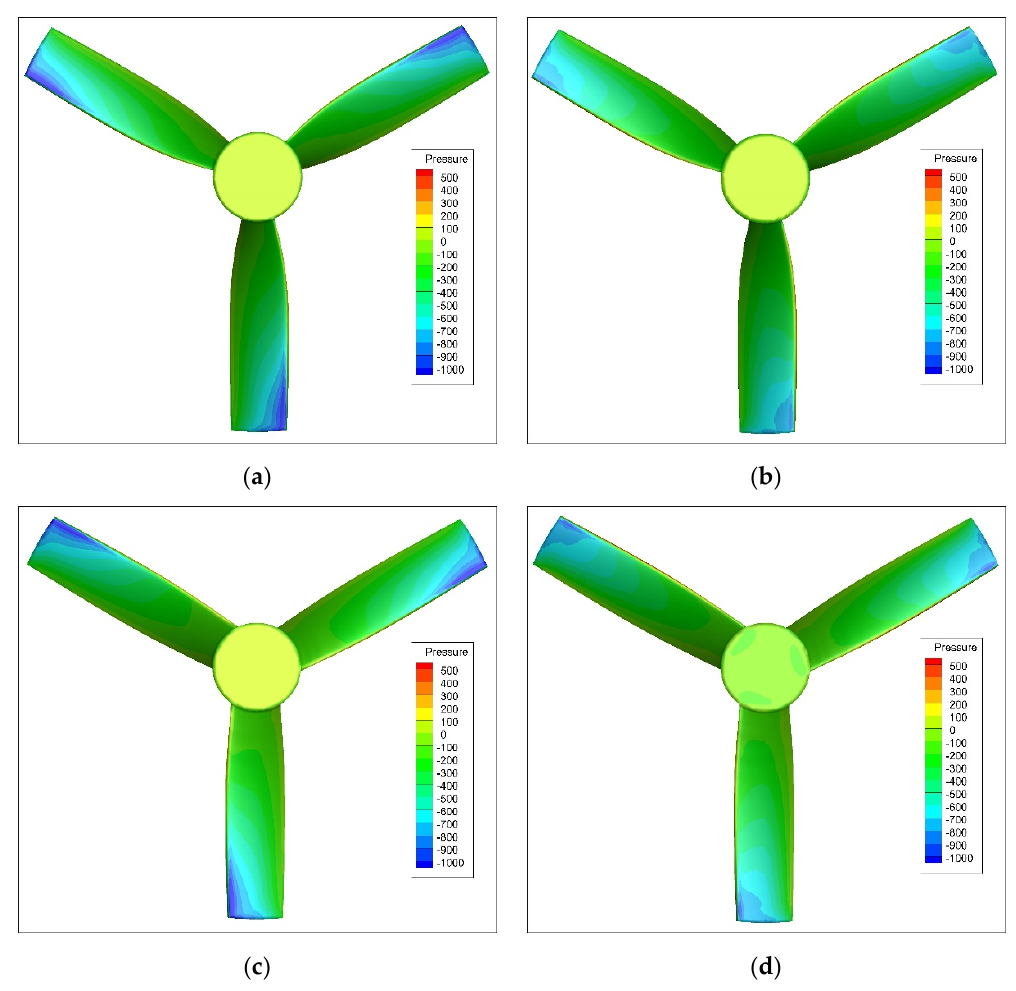
Figure 17. Static pressure contours of ducted single and coaxial propellers: ( a ) Ducted single upper propeller; ( b ) Ducted coaxial upper propeller; ( c ) Ducted single lower propeller; ( d ) Ducted coaxial lower propeller.